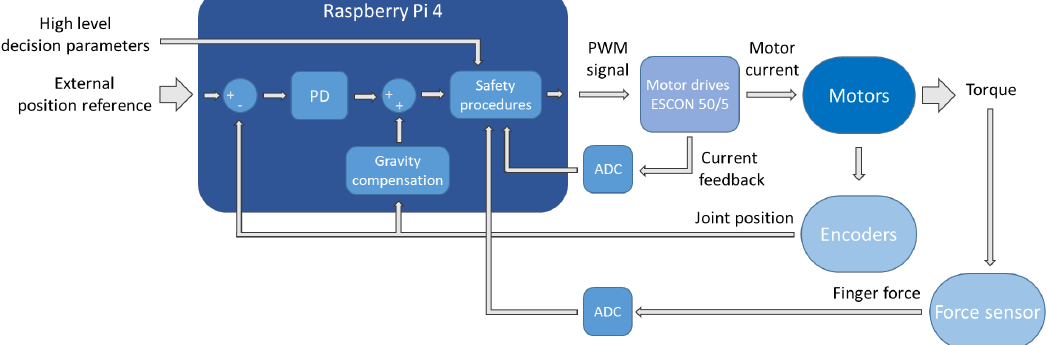
Figure 4. A block diagram for the passive mode of operation with all the used hardware and signals.